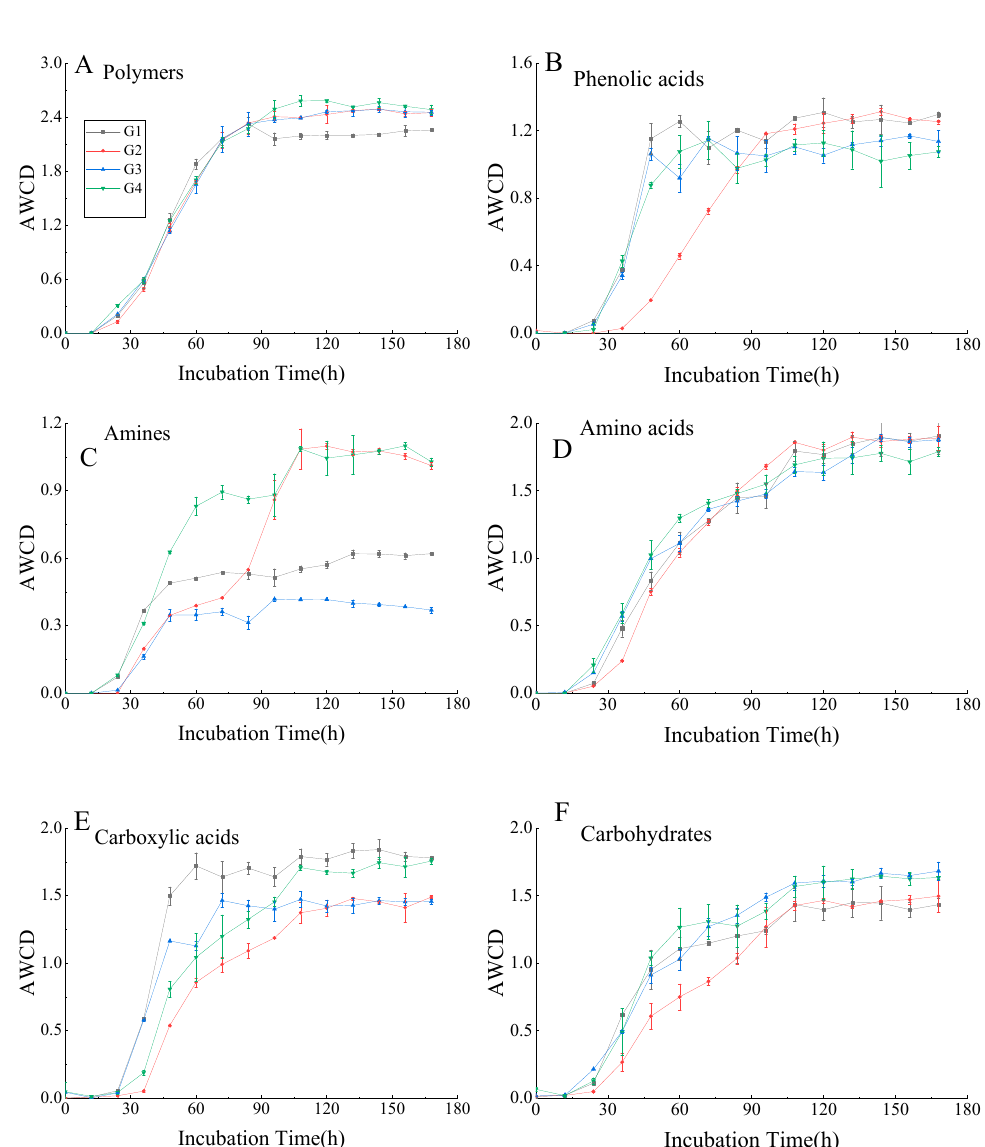
Figure 4. The AWCD of six types of carbon sources in the four sediment microbial communities, including polymers ( A ), phenolic acids ( B ), amines ( C ), amino acids ( D ), carboxylic acids ( E ), and carbohydrates ( F ).